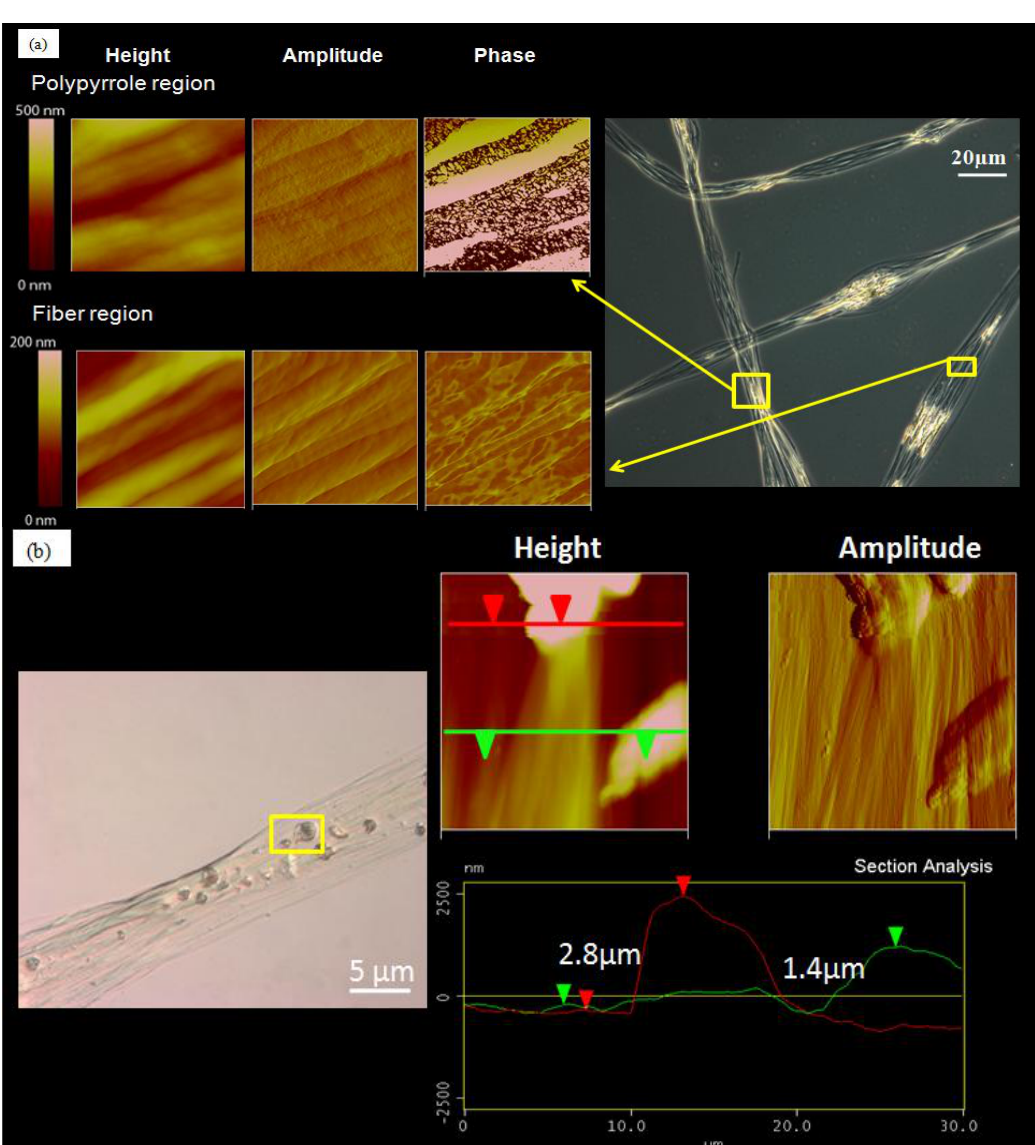
Figure 2. ( a ) AFM imaging of PPy-PEC fibers showing the height, amplitude and phase images of polypyrrole regions and fiber regions (where polypyrrole particles were absent).The obtained images are compared with the optical image of the scanned fiber regions (indicated by the boxes and arrows). AFM scan bars for polypyrrole regions and fiber regions are 2 µm and 1 µm respectively. ( b ) AFM imaging and section analysis of polypyrrole particles that were incorporated in PPy-PEC fibers. The AFM scan bar of the height and amplitude images is 10 µm. ( c ) Mechanical properties of PPy-PEC and PEC fibers (mean ± SD, n =